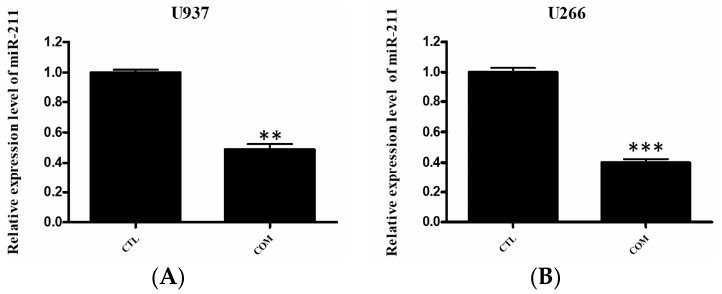
Figure 7. The effect of COM suppressed the expression of miR-211 in U937 and U266 cells. In U937 ( A ) and U266 ( B ) cells, miR-211 levels was determined by a qRT-PCR array after 24 h COM (80 µg/mL) treatment. Values represent the means of three experiments ± SD; ** p < 0.01, *** p < 0.001, versus untreated control.